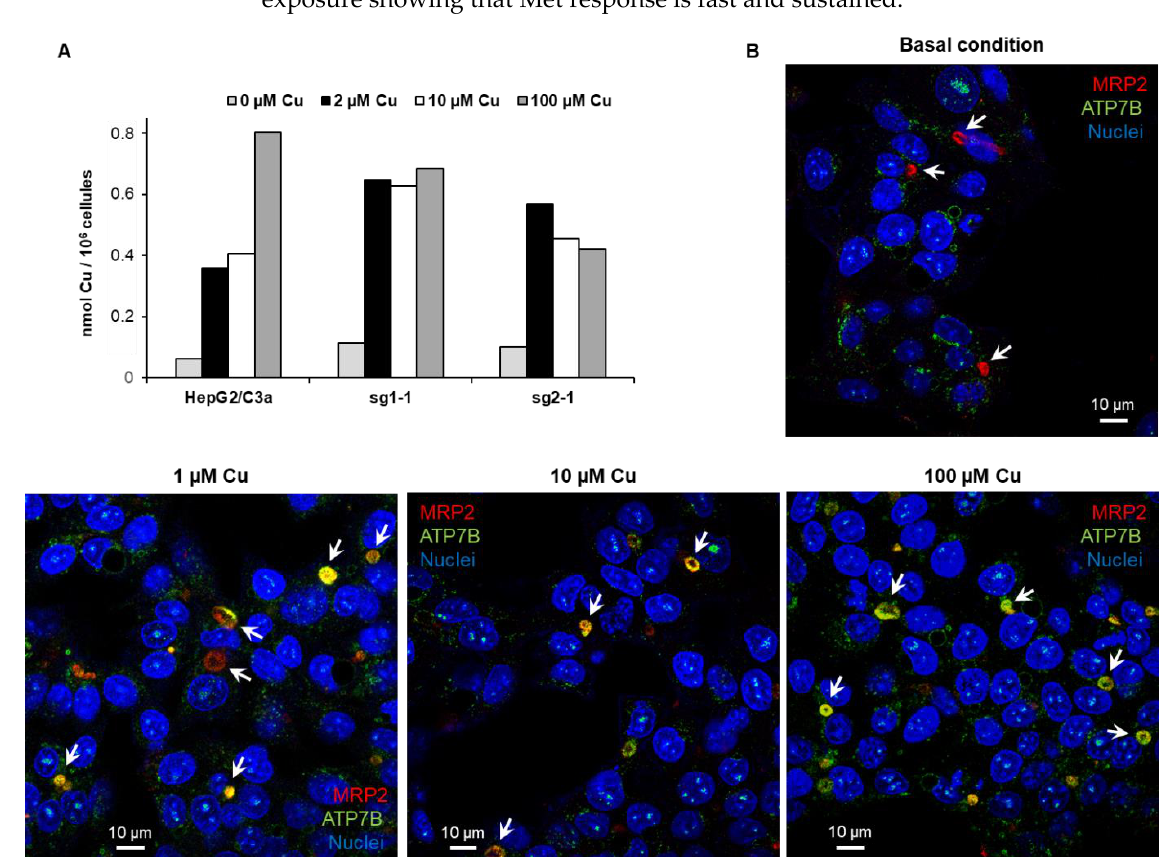
Figure 4. Cu accumulation in the different cell lines and ATP7B trafficking. ( A ) Amount of intracel- lular Cu for the HepG2/C3a, sg1-1, and sg2-1 cell lines upon exposure to increasing concentrations of Cu. ( B ) Analysis of ATP7B (green) localization by immunofluorescence in HepG2/C3a cells ex- posed to different concentrations of Cu. ATP7B is green, MRP2, a marker of bile canaliculi, is red, and nuclei are blue. White arrows pinpoint bile canaliculi.